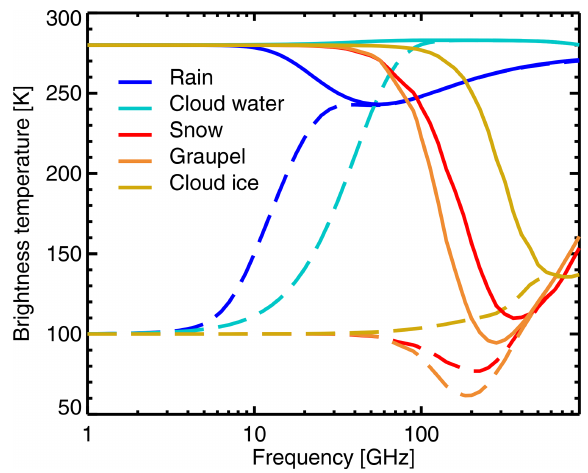
Figure 8. Cloud-top brightness temperatures simulated from uni- form slabs composed of one of the default hydrometeor types (see legend, also Table 1) present in a 2km thick layer with a water content of l = 1 × 10 − 3 kgm − 3 . The cloud temperature is 253K if frozen (snow, graupel or cloud ice) or 283K if melted (rain, cloud water). Upwelling brightness temperature below the cloud is 280K (solid lines) or 100K (dashed